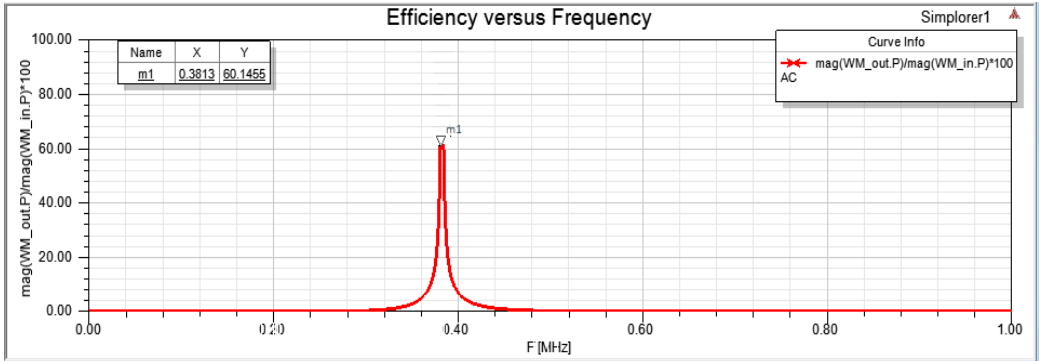
Figure 27. Efficiency and frequency for the inductive coupling technique.